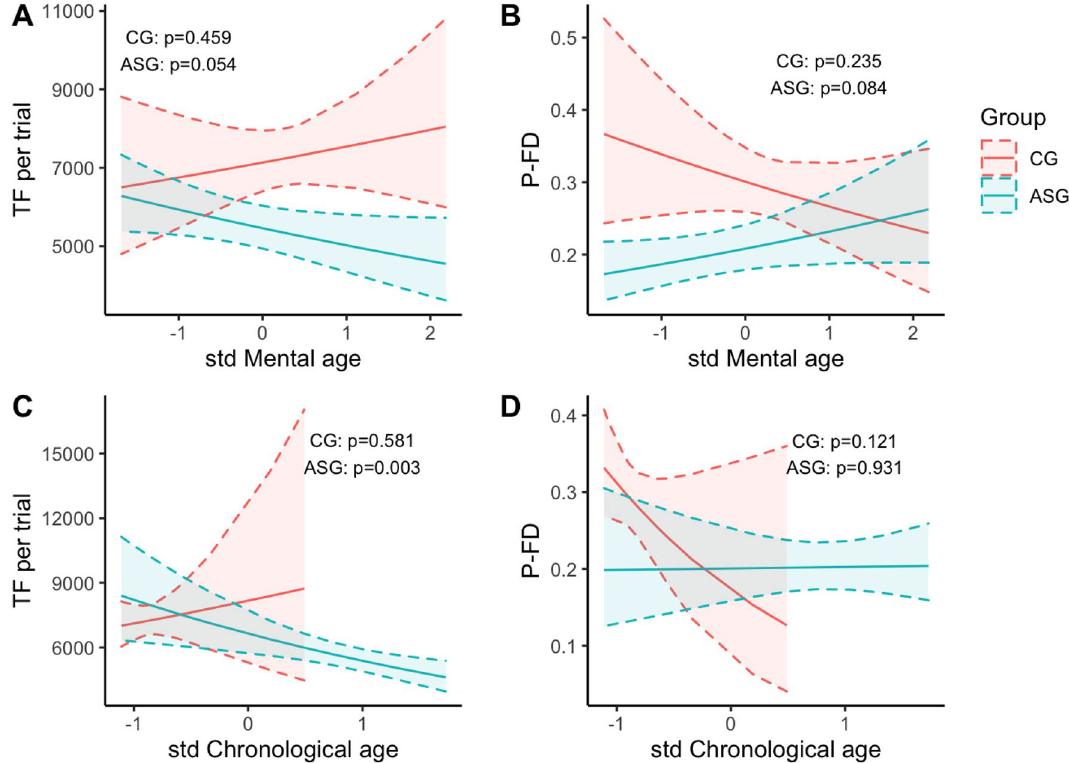
Figure 2. Results from the mixed effect models obtained to test for the association between mental age and TF—total fixations duration—( A ) and P-FD—proportion of fixation duration—( B ) and between chronological age and TF ( C ) and P-FD ( D ). TF is expressed in milliseconds and is considered per trial. Chronological and mental age were standardized. The dashed lines represents the 95% confidence intervals estimated by the regression